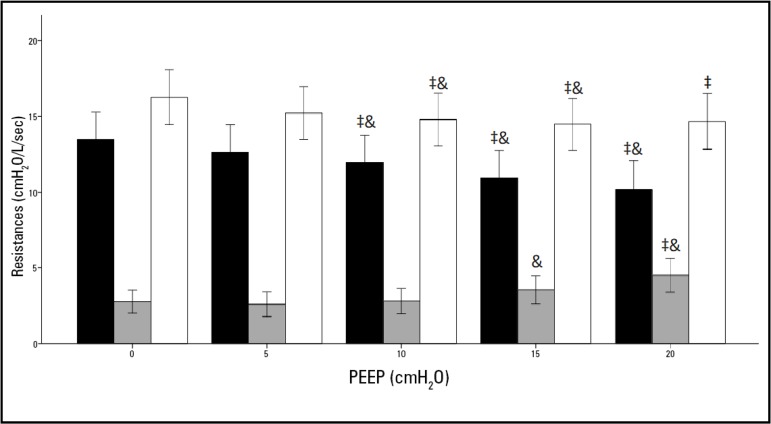
Variations in the maximum (white bars), minimum (gray bars) and differential (black bars) resistances of the respiratory system with different of positive end-expiratory pressure levels; post hoc test with Bonferroni correction (‡ versus 0cmH2O PEEP, < 0.05, & versus 5cmH2O PEEP, < 0.05). PEEP - positive end-expiratory pressure.